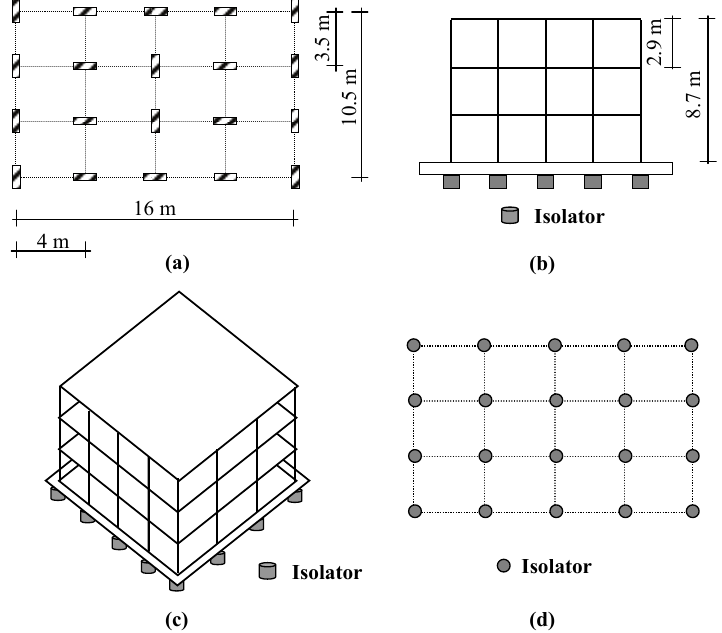
Fig. 4. 3-D model of 3-story isolated RC building: (a) plan, (b) elevation, (c) 3D layout, and (d) isolation